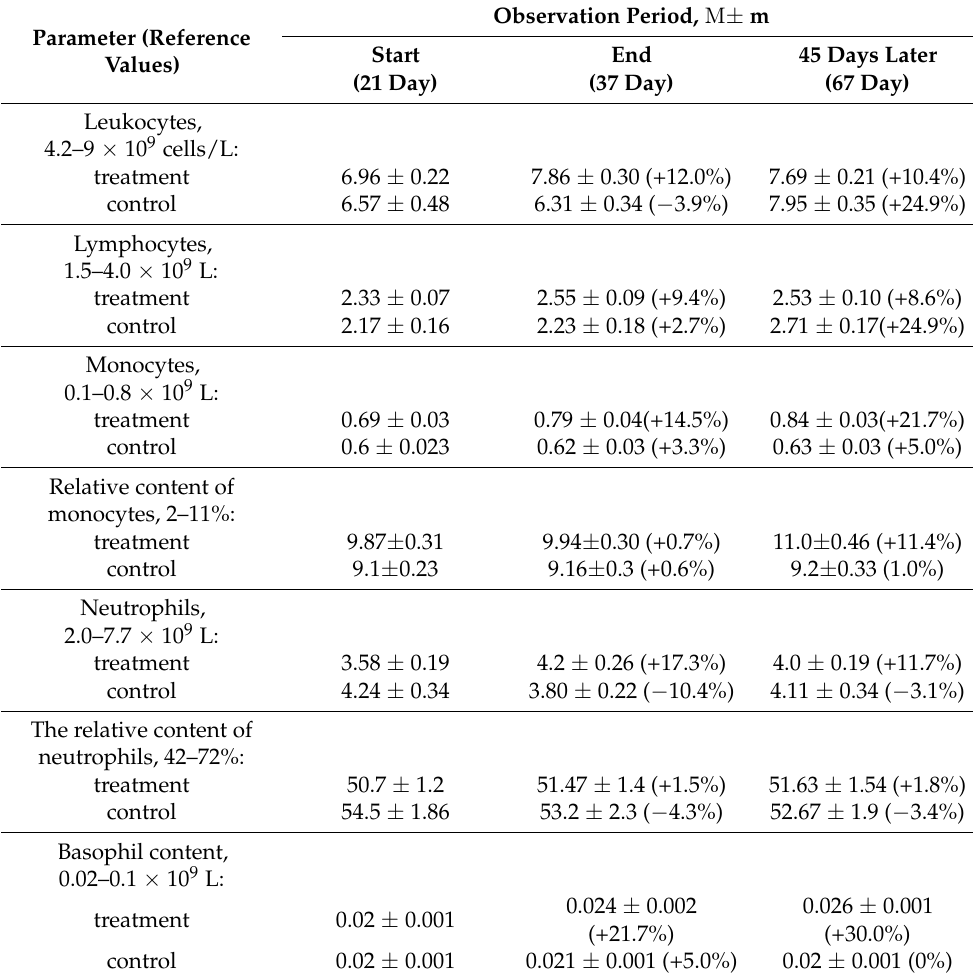
Table 7. White blood cells during the food intervention (absolute values).